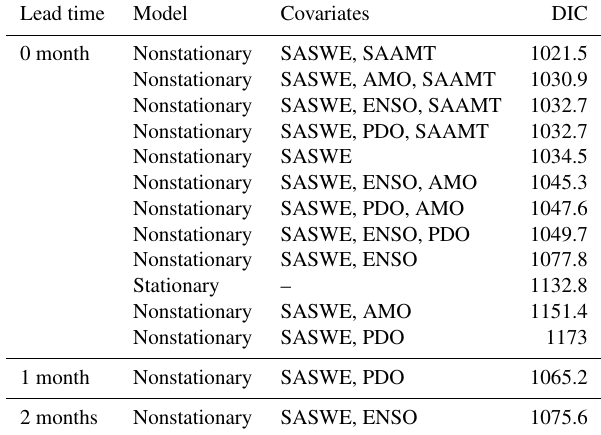
Table 2. DIC values for different candidate BHMs for a 0-month lead time and the best model for the other two lead times. For each model, the same covariates for the location parameter are consid- ered at all gauges. Candidate BHMs are sorted from the lowest to the highest DIC value for a 0-month lead time. Scale and shape pa- rameters are considered stationary. All candidate BHMs consider a Gaussian copula to model spatial